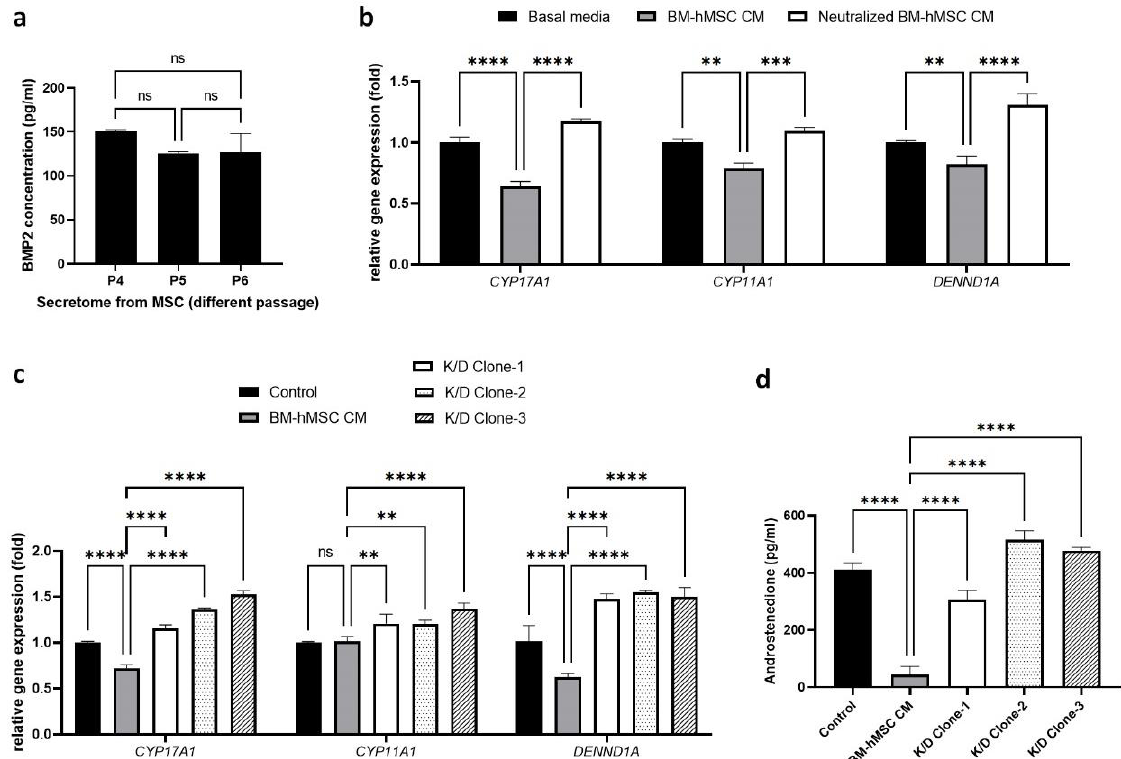
Figure 3. BMP-2 secretion in BM-hMSCs. ( a ) BMP-2 concentration in different passages of BM-hMSCs, P3: 150.75 ± 1.76, P4: 124.5 ± 1.78, P5: 127.0 ± 21.21. ( b ) Effect of neutralized secretome on androgen synthesizing genes’ (CYP17A1, CYP11A1, and DENND1A) expression. Relative gene expression in Control H295R cells (basal media), MSC conditioned media-treated H295R cells (BM-hMSC CM), and BMP2 neutralized conditioned media-treated H295R cells (Neutralized CM). ( c ) Effect of BMP-2 knockdown MSCs clone secretome on androgen-synthesizing genes’ (CYP17A1, CYP11A1, and DENND1A) expression. ( d ) Effect of BMP-2 knockdown MSCs clone secretome on androstenedione synthesis. Data are presented as the mean ± SD. ( n = 3, significance level, ** p < 0.005, *** p < 0.0005, **** p < 0.0001; ns: Not